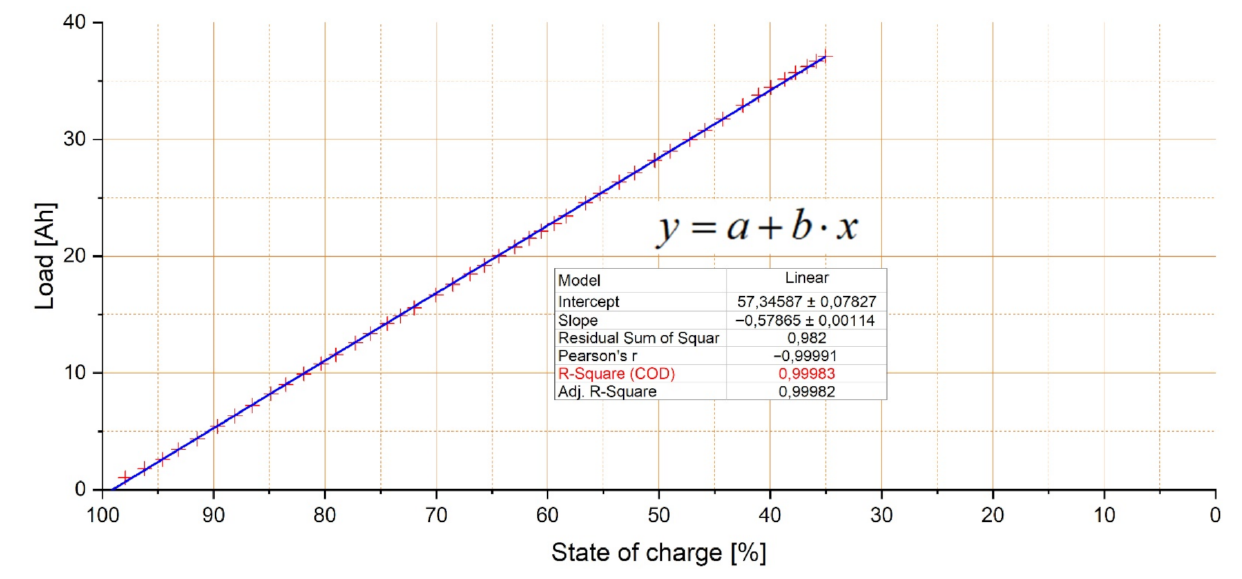
Figure 13. Battery discharge—load as a function of the state of charge.